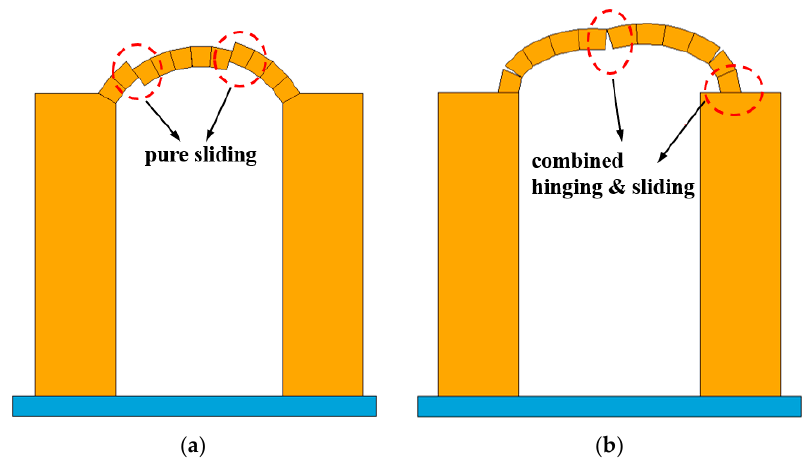
Figure 20. Sliding failures: ( a ) pure sliding, buttressed circular arch, β = 120°, μ = 0.2, λ = 0.16; ( b ) combined hinging and sliding, buttressed basket-handle arch, β = 180°, μ = 0.6, λ = 0.16.